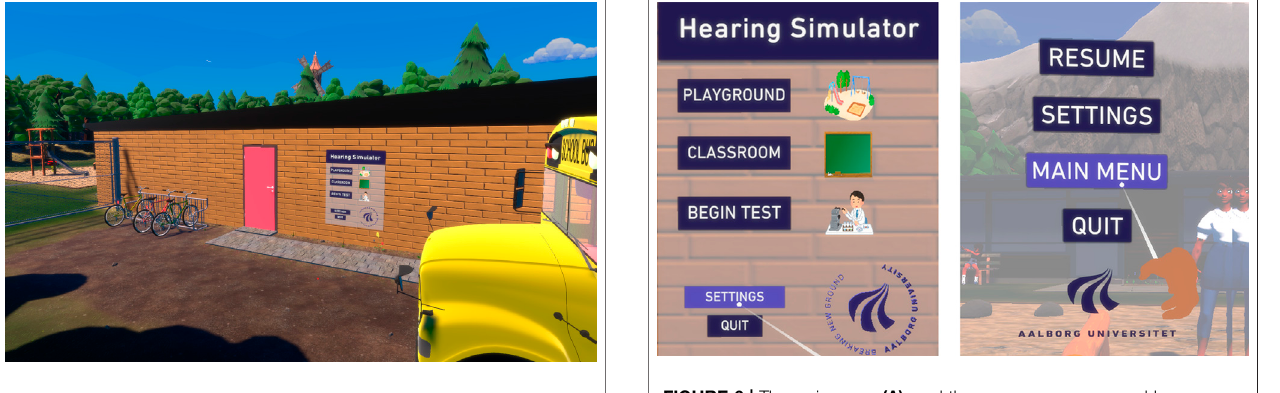
FIGURE 5 | The menu scene, in which participants are initially spawned upon launching the simulation.